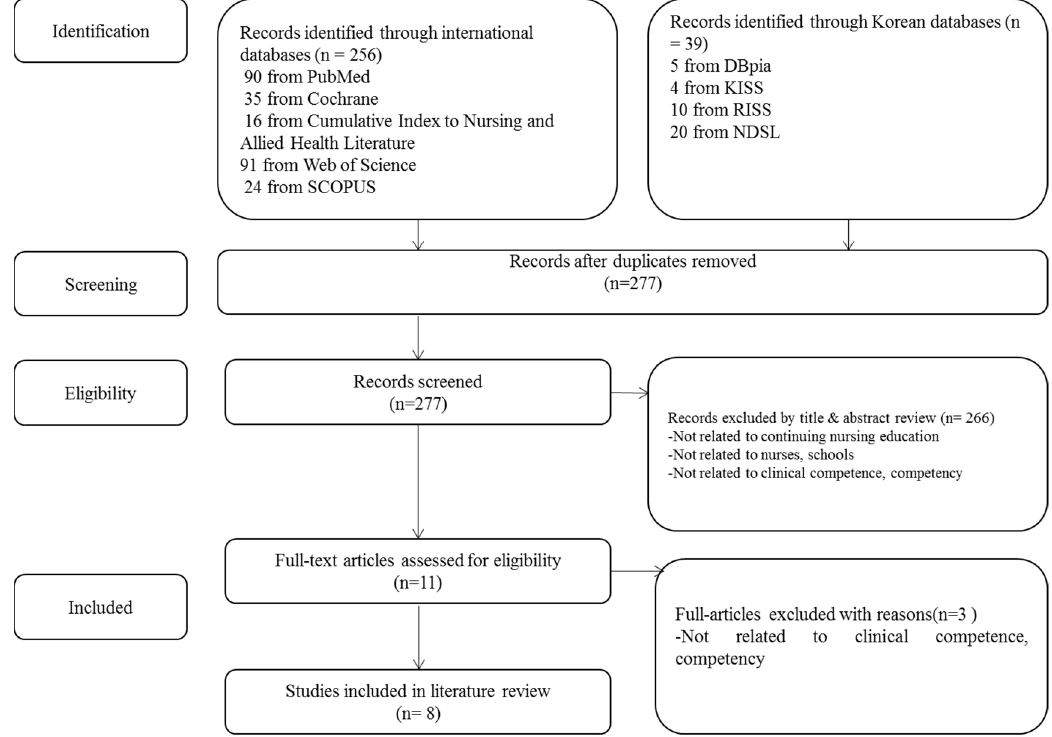
Figure 1. Flow chart of the study selection process.